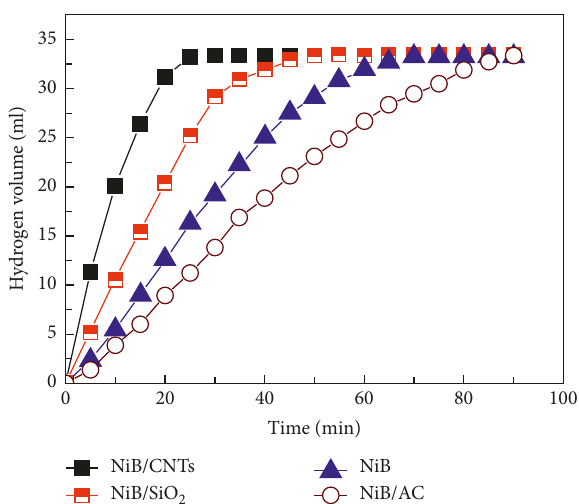
Figure 3: Catalytic activity test of NiB and the supported catalysts for catalytic hydrolysis of NaBH